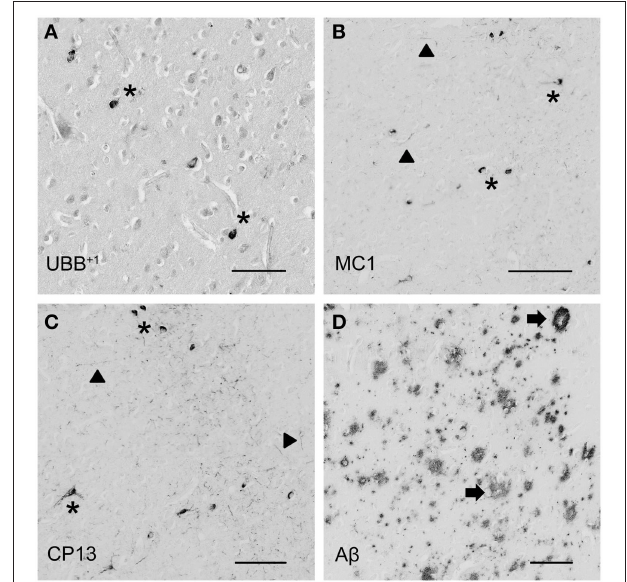
FIGURE 3 | Expression of UBB + 1 and AD neuropathology (NFTs, NTs and A β ) in sections of the human olfactory bulb and tract of patient #10 (Braak 6). (A–D) shows olfactory tissue incubated with antibodies against (A) UBB + 1 , (B) pre-tangles (MC1), (C) tangles (CP13), and (D) A β plaques. Asterisk shows intracellular accumulations, represented by neuronal staining (A) UBB + 1 immunoreactivity present in neuronal cells of the OB ( asterisk ). (B–C) Presence of misfolded tau in pretangles and NFTs (asterisk) . NTs are shown by the filled triangles . (C) The insert shows the AON of the tract. (D) Presence of A β plaque formation (arrow). Bars: (A–D) , 100 µ m, insert in (C) , 500 µ m. AON, anterior olfactory nucleus.